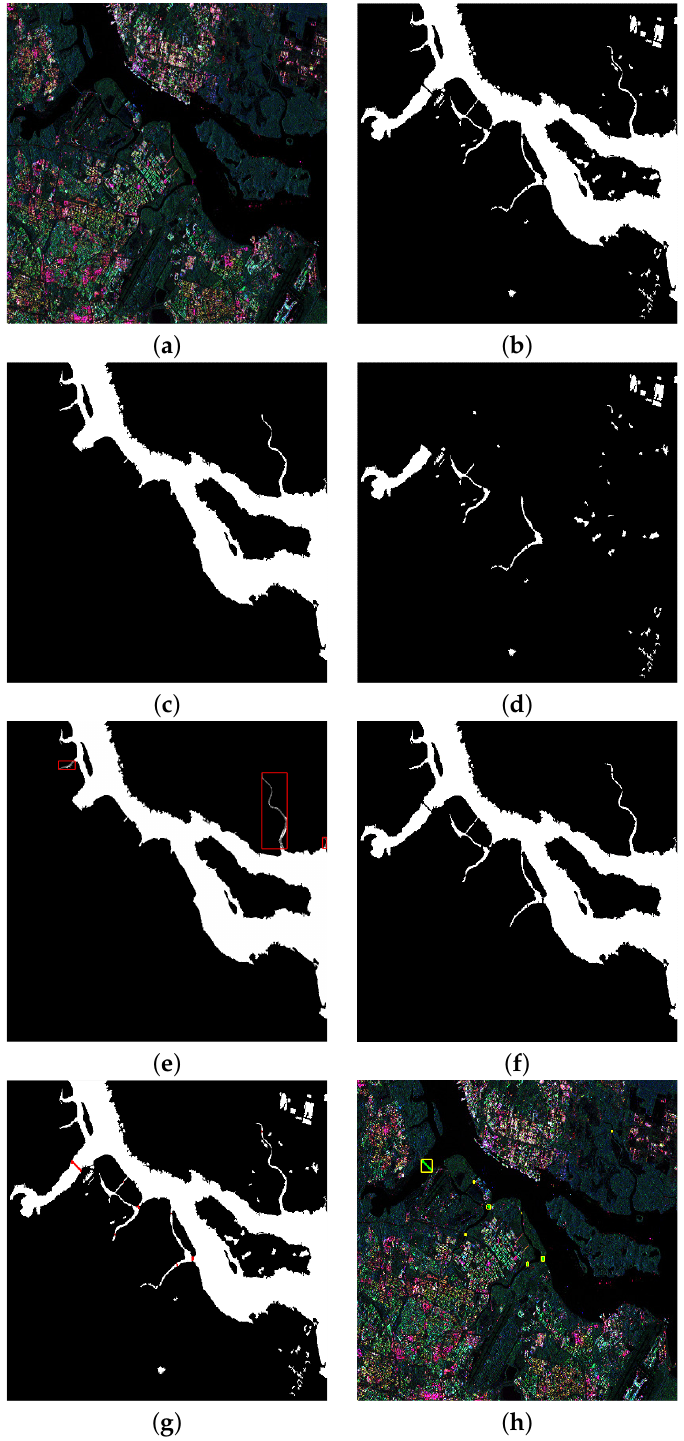
Figure 10. Bridge detection result of data in part of Singapore region: ( a ) the Pauli pseudocolor image; ( b ) water and land segmentation result using level set; ( c ) the extracted main water; ( d ) water branches other than the main water, where the regions in gray marked in the red box are the scanned bifurcations; ( e ) the bifurcation scanning result; ( f ) the water network connection result; ( g ) the bridge detection and bridge body extraction results, where the detected bridge bodies are marked in red; ( h ) the detection results in the original image, where the detected bridges are marked by yellow boxes and the bridge bodies are drawn in